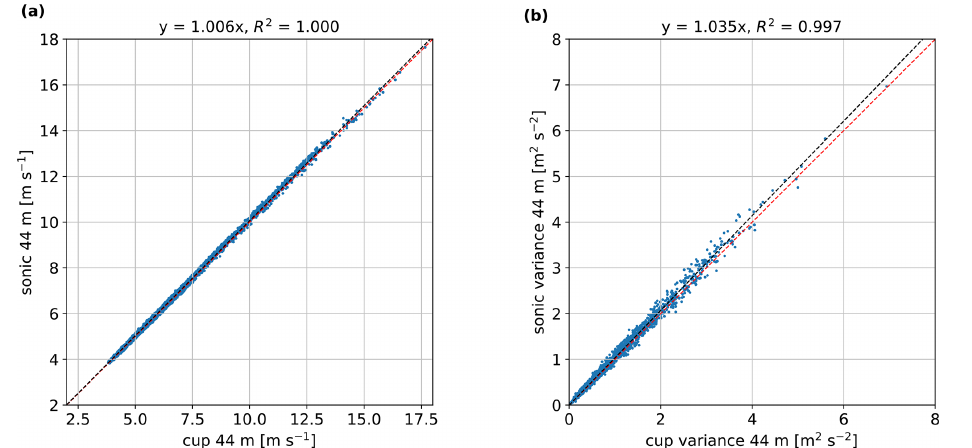
Figure 9. Comparison of the 10min mean horizontal (a) wind speed and (b) variance between the sonic and the cup anemometers at 44m. Each 10min is shown in blue markers, a 1 : 1 relation is shown in the red dashed line, and a linear regression fit to origin in the black dashed line (results of the regression are given on the top of the plot, where R 2 is the coefficient of determination).